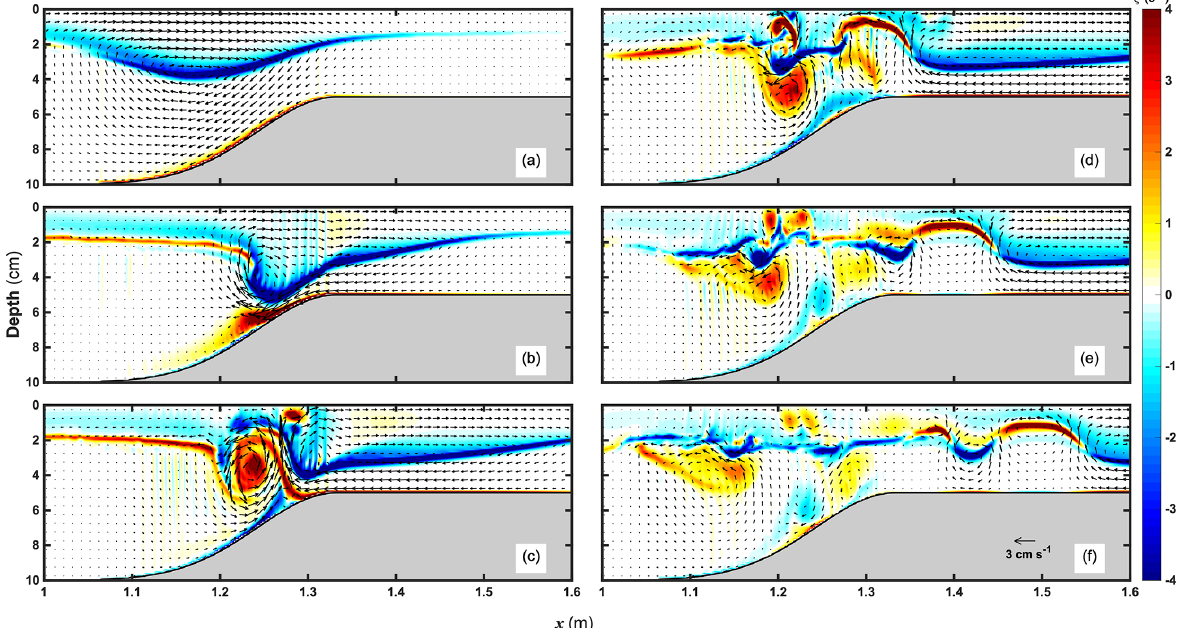
Figure 10. The shoaling of a depression soliton with the velocity fields (black arrow) and the vorticity results (color) shown at t = (a) 35,